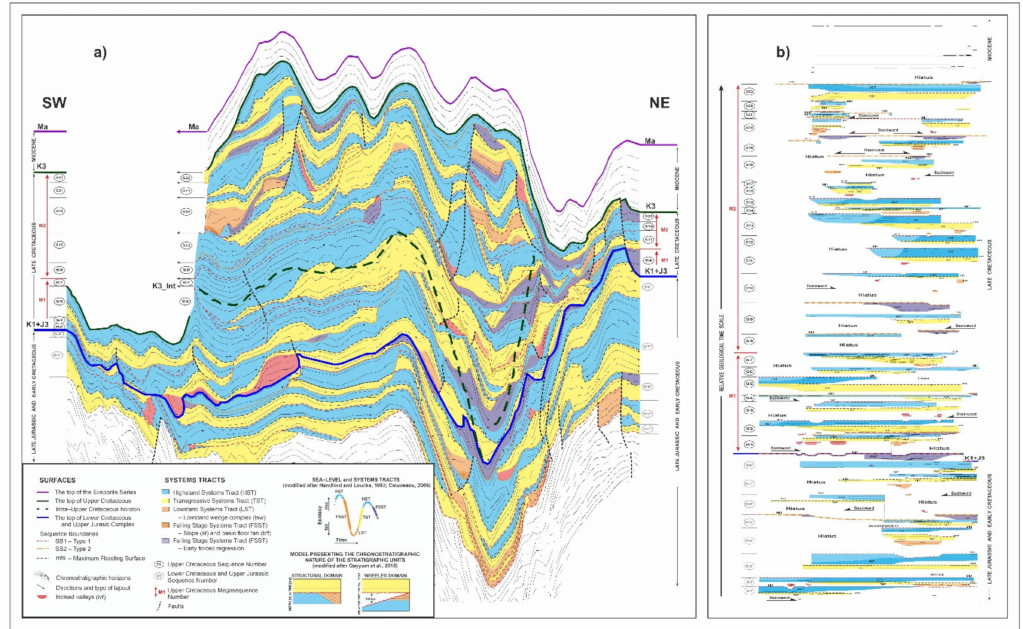
Figure 4. Detailed sequence stratigraphy and tectonostratigraphy interpretation of ( a ) chronostratigraphic horizons in structural domain and ( b ) Wheeler diagram transformed from seismic